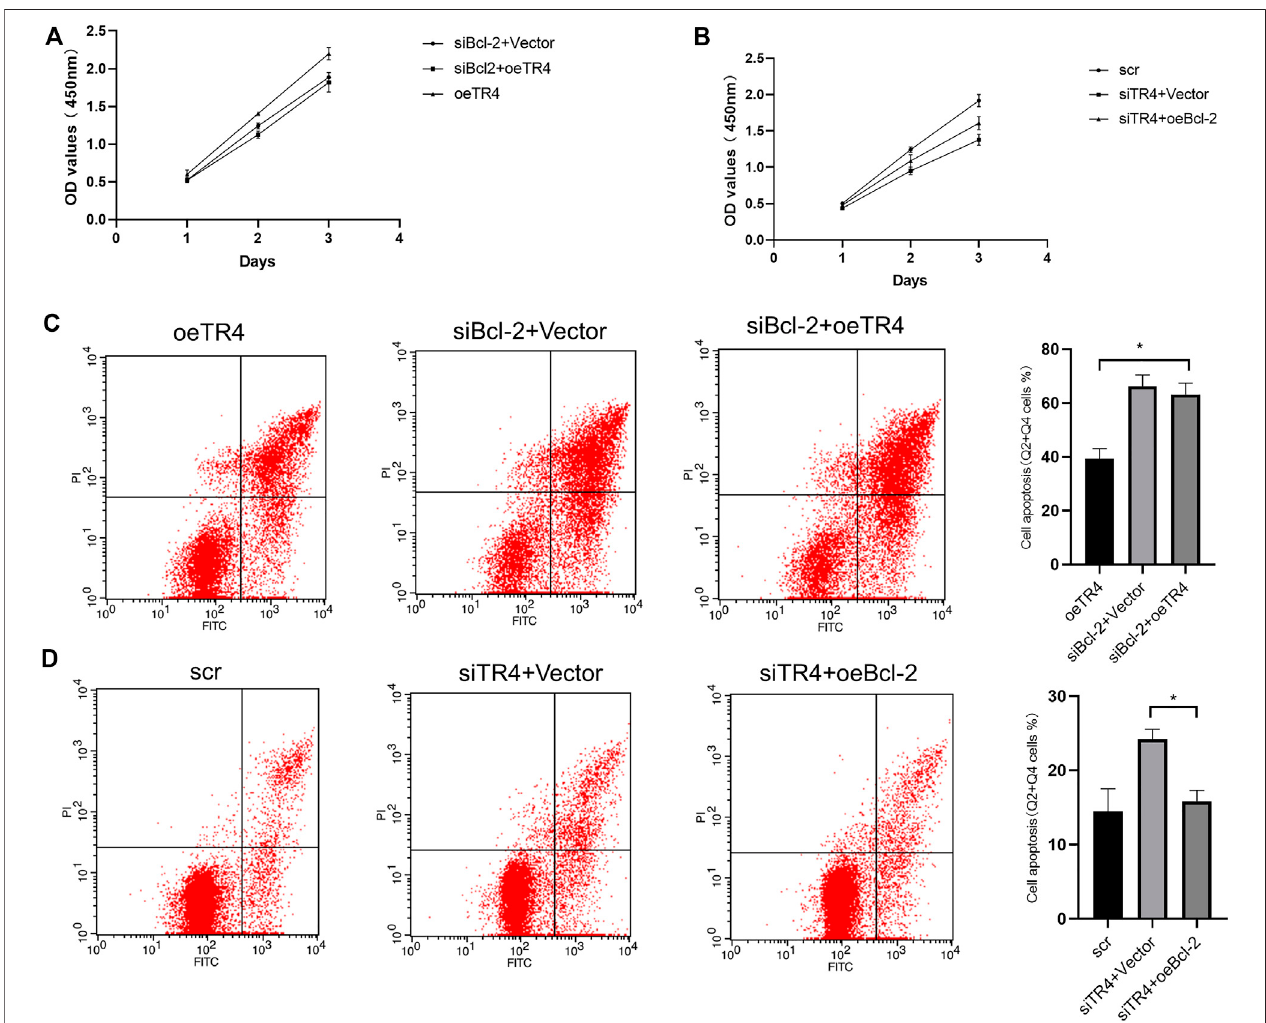
FIGURE 5 | The effect of TR4 on apoptosis is dependent on Bcl-2 in T24 cells: (A) CCK8 was used to measure the proliferation after knocking down the Bcl-2 expression in oeTR4-T24 cells. (B) CCK8 was used to measure the proliferation after overexpressing Bcl-2 in siTR4-T24 cells. (C) Flow cytometry assay was used to evaluate the apoptosis after knocking down the Bcl-2 expression in oeTR4-T24 cells, * p < 0.05. (D) Flow cytometry assay was used to evaluate the apoptosis after overexpressing Bcl-2 in siTR4-T24 cells, * p < 0.05.